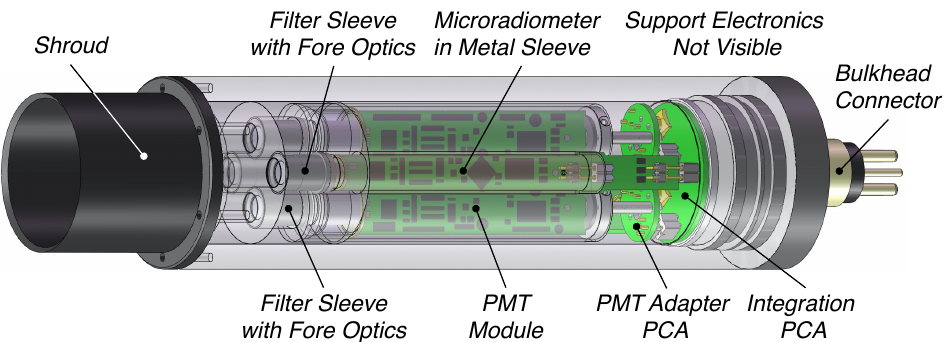
Figure 7. Two paired PMT-microradiometer radiance sensor dyads with a 1.7in (4.3cm) diameter and 1.5 in (3.8cm) long removable shroud attached to a 2.0in (5.1cm) diameter housing that is 9.7in (24.6cm) long and a total weight of 2.1lb (1.0kg). Following from the common architecture in the irradiance dyad, the radiance sensor shown is pressure rated to 2000m for in-water deployments. Mass reductions exceeding 25% are easily achieved for above-water